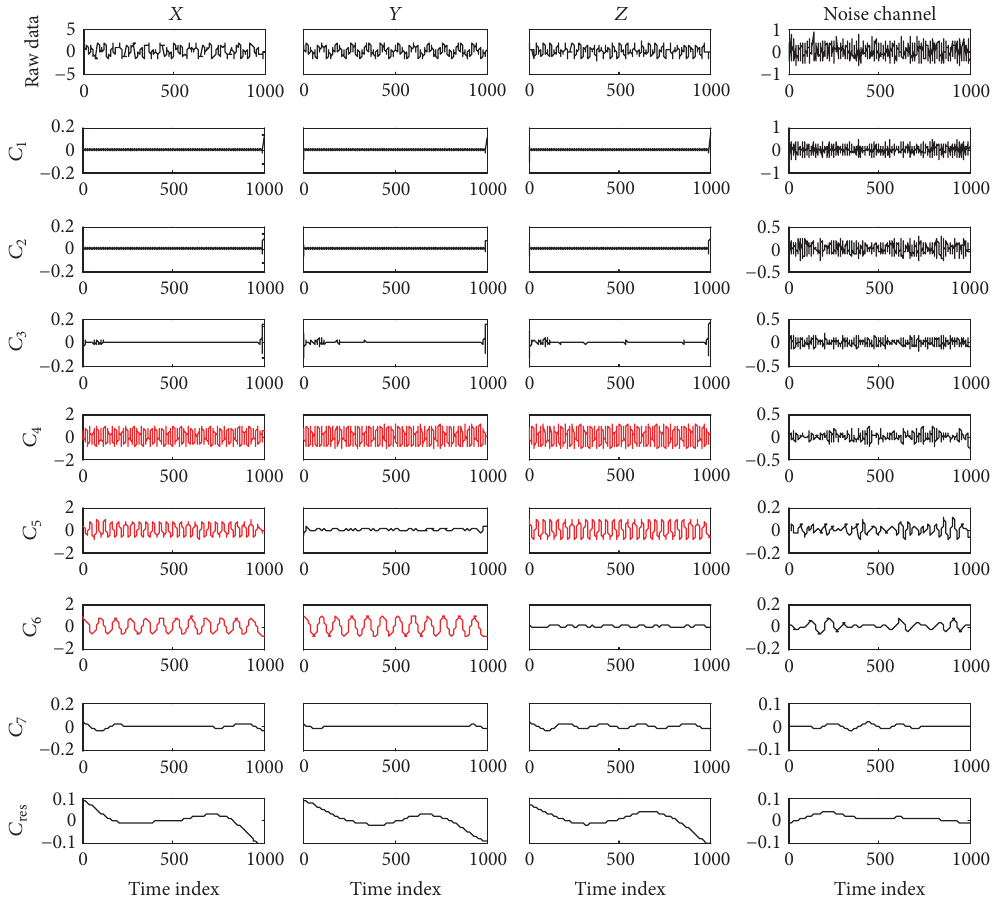
Figure 3: Decomposition results of the simulated data using the NA-MEMD